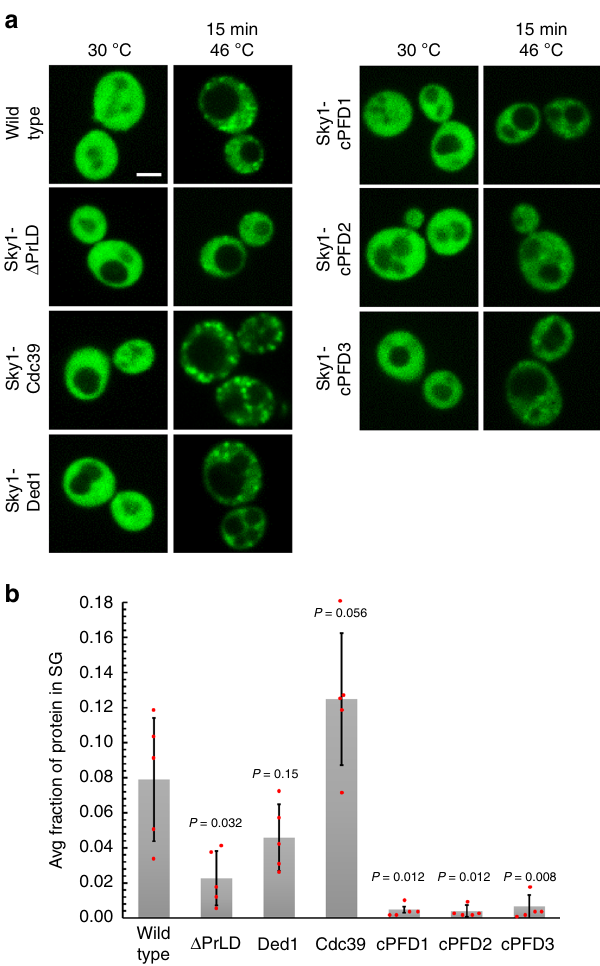
Fig. 3 Other PrLDs can replace the Sky1 PrLD to support stress granule recruitment. a Yeast strains were generated expressing from the endogenous SKY1 locus versions of Sky1-GFP in which the core PrLD was deleted ( Δ PrLD), replaced with the PrLDs from Cdc39 or Ded1, or replaced with nonaggregation-prone PrLDs (cPFD#1, cPFD#2, and cPFD#3). Cells were grown to mid-log, then subjected to heat shock at 46 °C for 15